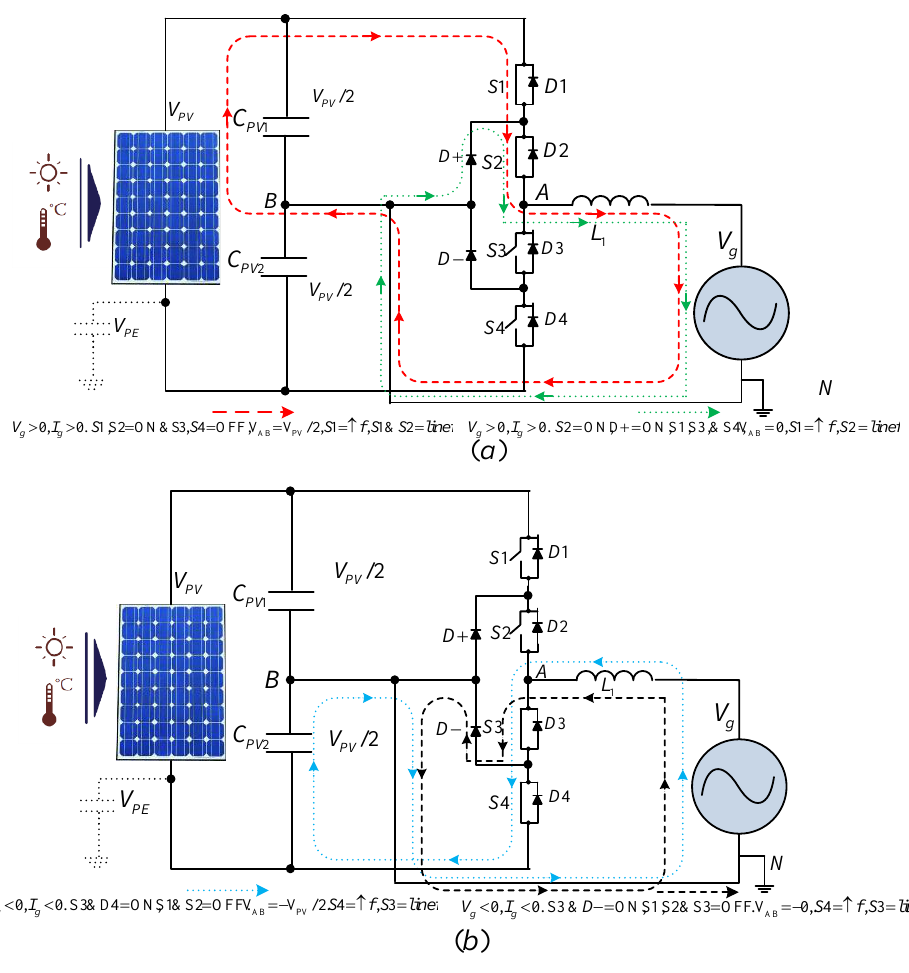
Figure 18. Switching positions of NPC HB in case of: ( a ) positive cycle and ( b ) negative cycle [29,30].